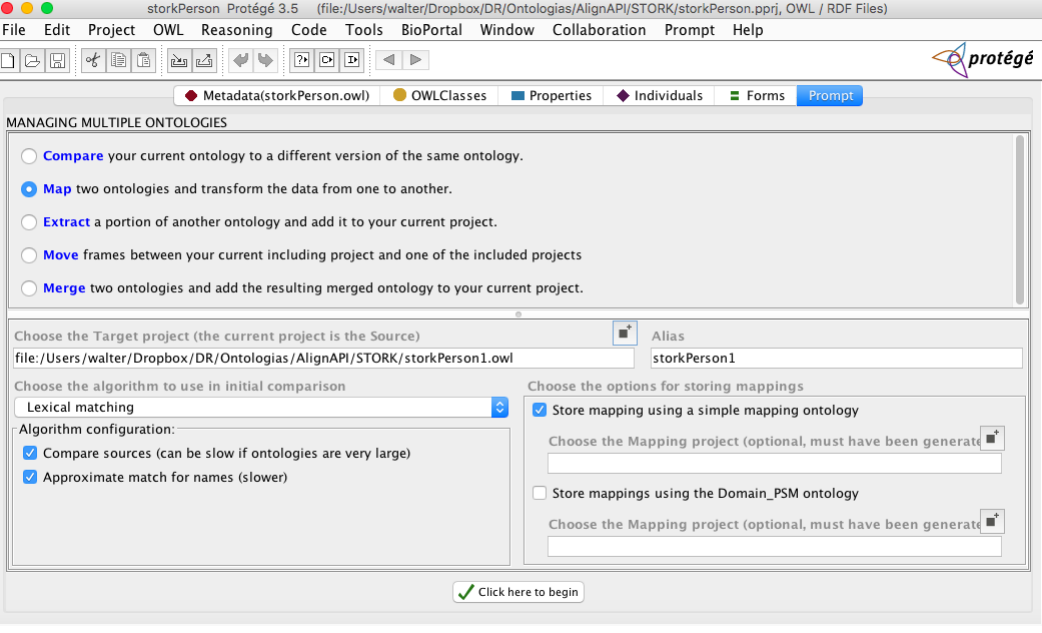
Figure 3. Main user interface of